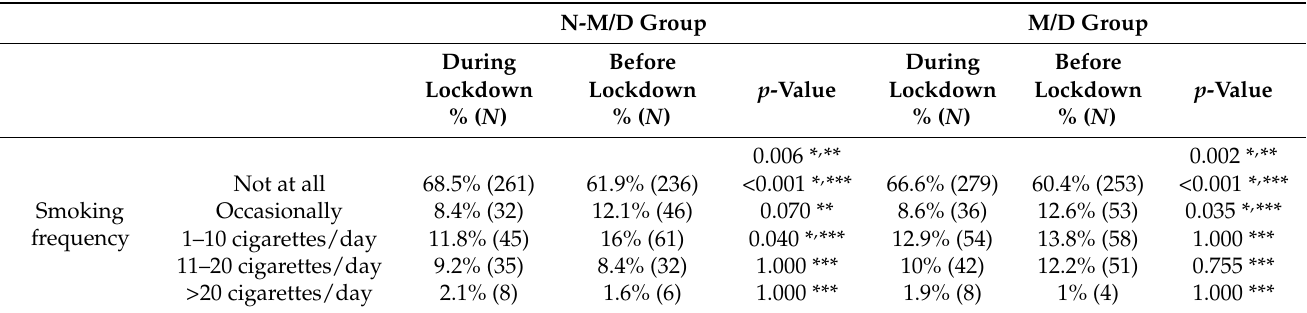
Table 3. Smoking habit changes between pre-lockdown and during the COVID-19 lockdown, among medical/dental professionals and the general